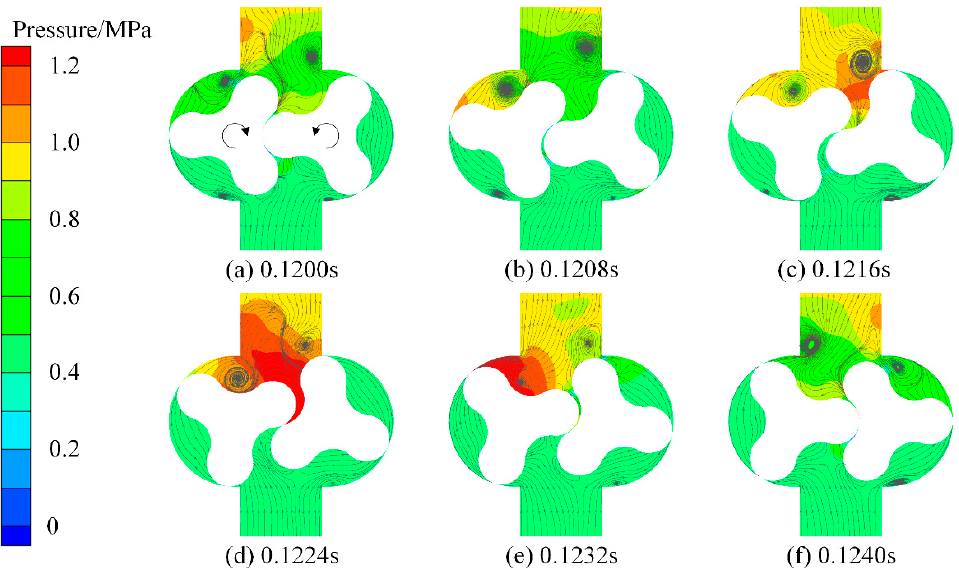
Figure 8. Pressure streamline contours of the Roots pump when the inlet CO 2 volume fraction is 0.9. Flow time: ( a ) 0.1200 s; ( b ) 0.1208 s; ( c ) 0.1216 s; ( d ) 0.1224 s; ( e ) 0.1232 s; ( f ) 0.1240 s.